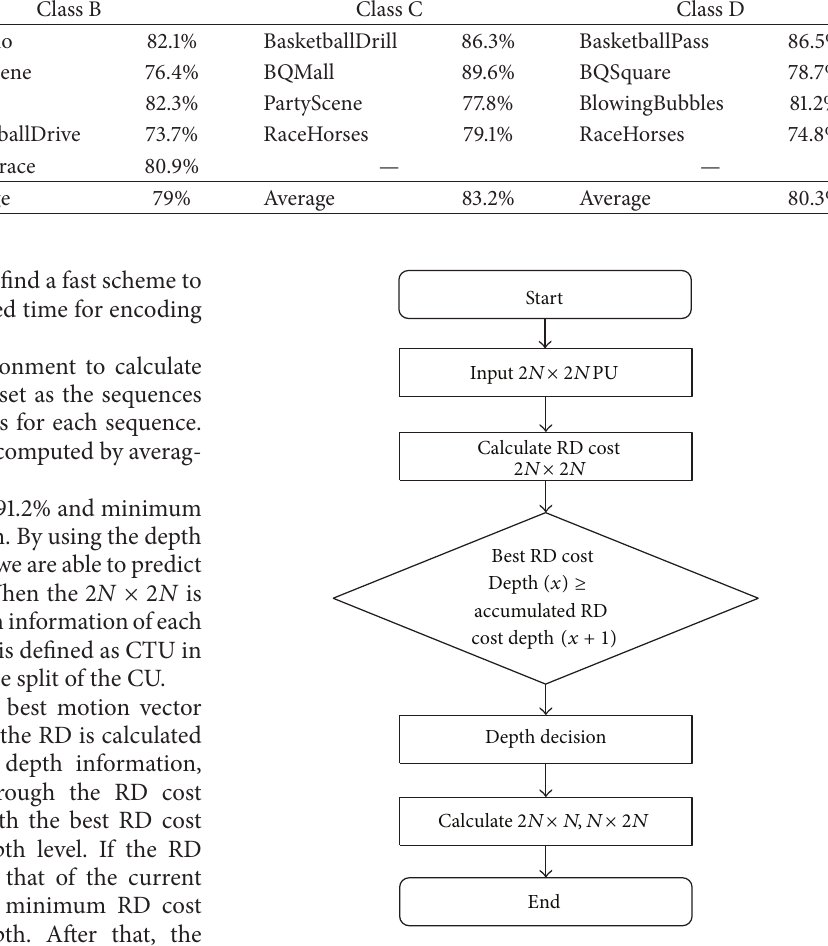
Figure 2: Flowchart of the proposed CU depth